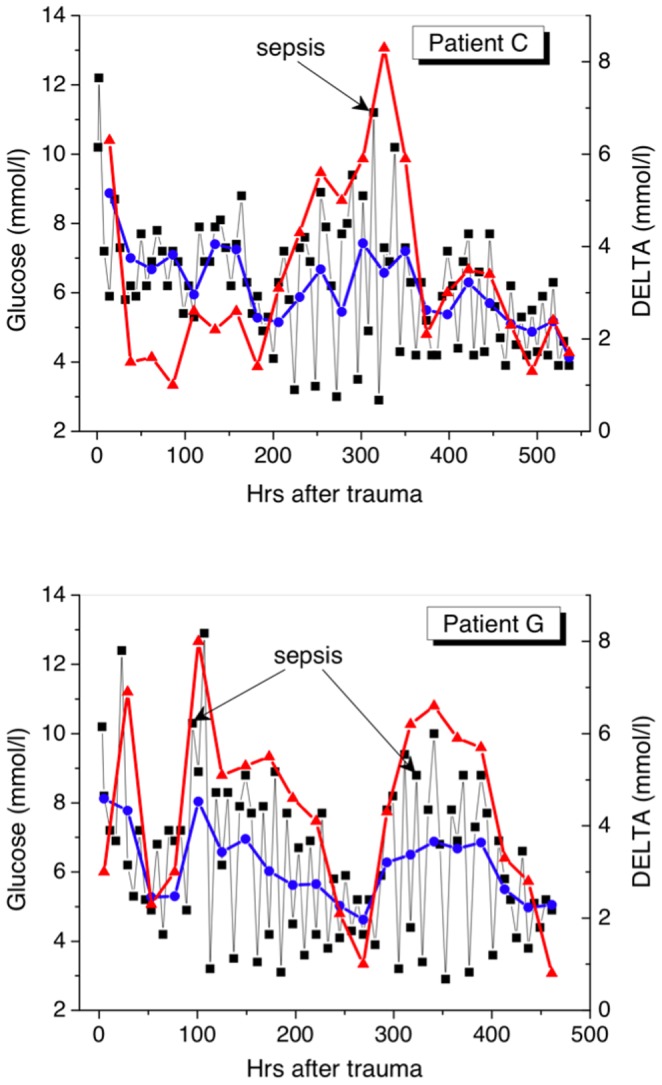
Time series of glucose measurements for patients from Group 2 (survivors with sepsis).The arrows indicate the measurements in which the blood culture was identified. DELTA reaches a maximum value in a sepsis state. Patient G had two sepsis episodes during his ICU stay.